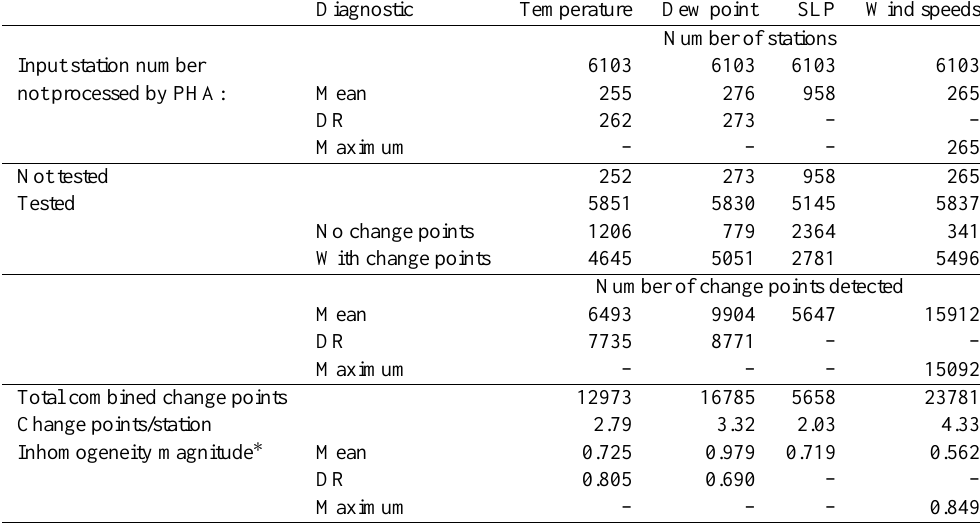
Table 1. Statistics of inhomogeneity detection fo HadISD